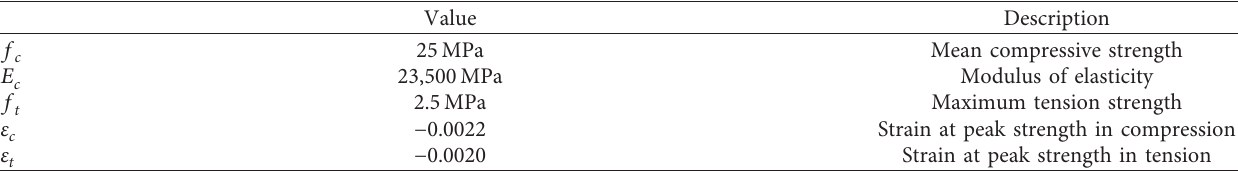
Table 1: Data required to generate the concrete stress-strain curve.